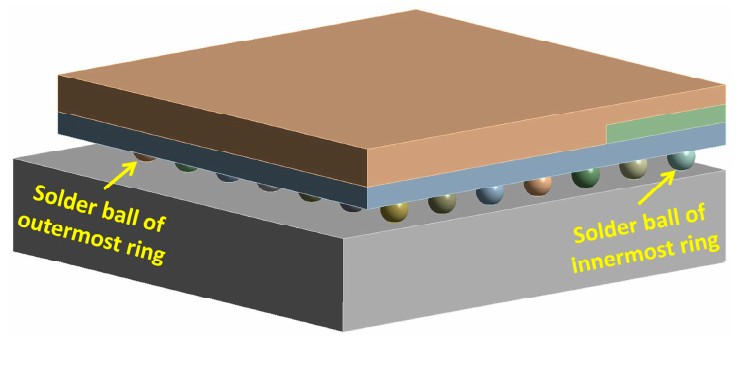
Figure 1. ( a ) PCB test board in thermal cycling test. ( b ) Temperature profile.